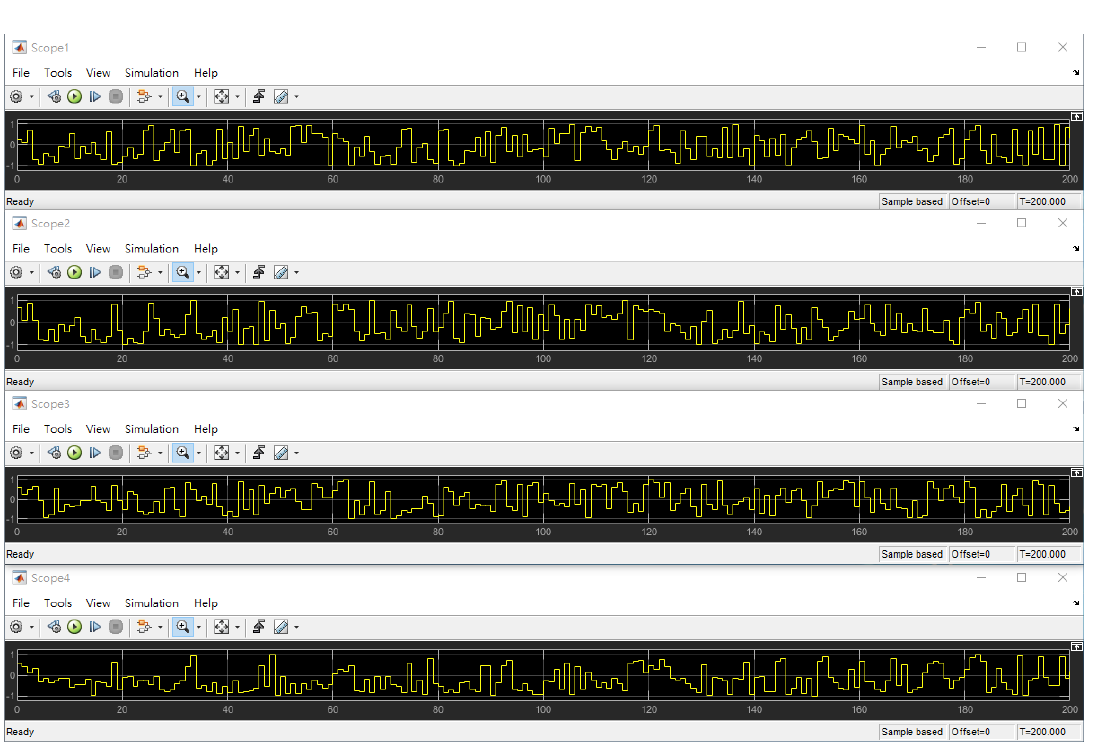
Figure 13. First 200 points of PAPRBS.